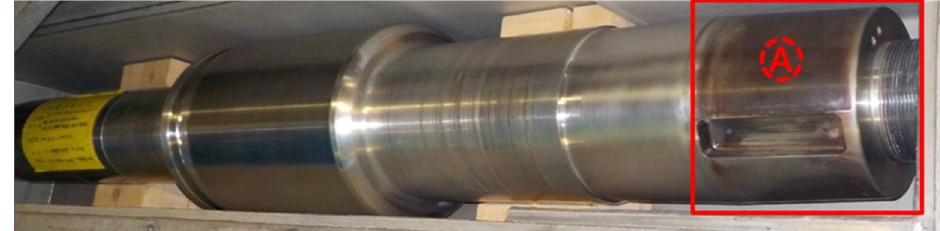
Figure 4. Contaminated RCP shaft from a nuclear plant.